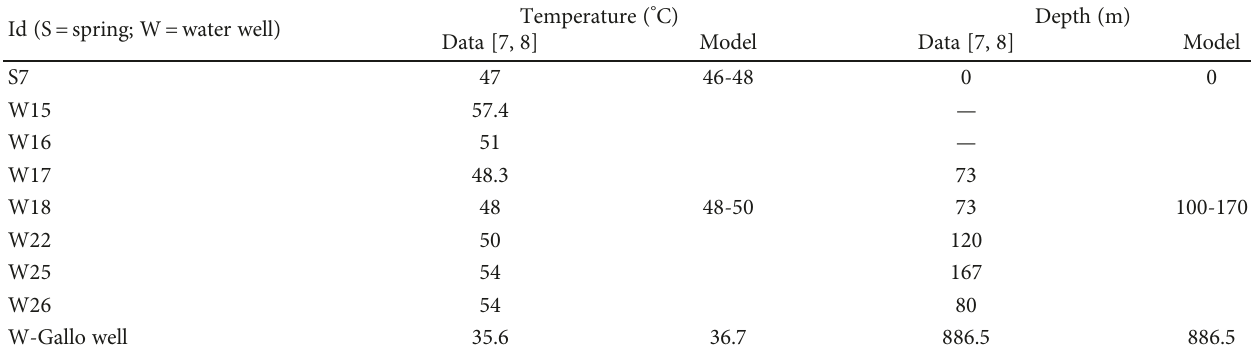
Table 3: Springs and water wells selected for the parameter optimisation. Id (S=spring; W=water